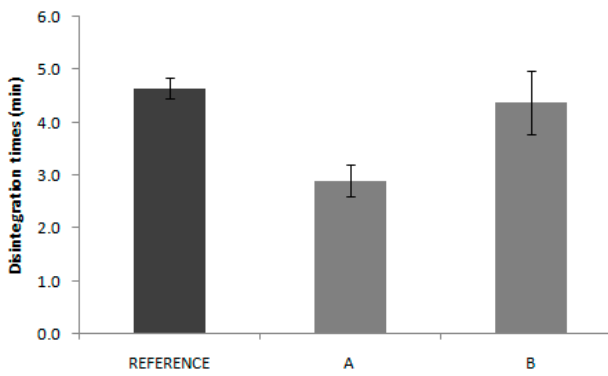
Figure 4. Disintegration times of candesartan cilexetil products (Reference, Product A and Product B) ( n = 6 tablets / product).